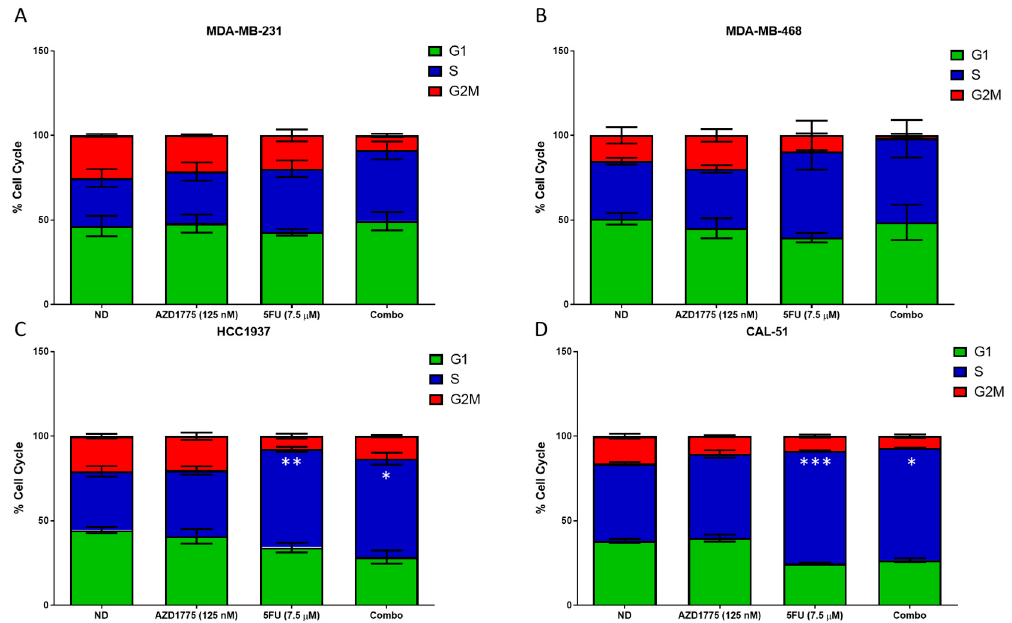
Figure 6. Cell cycle analysis of AZD1775 and 5FU in TNBC cell lines. Cells were treated with AZD1775 and 5FU and cell cycle arrest was assessed at 24 h using Krishans staining followed by flow cytometry. ( A ) MDA-MB-231, ( B ) MDA-MB-468, ( C ) HCC1937, and ( D ) CAL-51. A t-test was performed to compare the combination treated to each of the single agent (* = p < 0.05, ** = p < 0.01, **** = p < 0.0001).